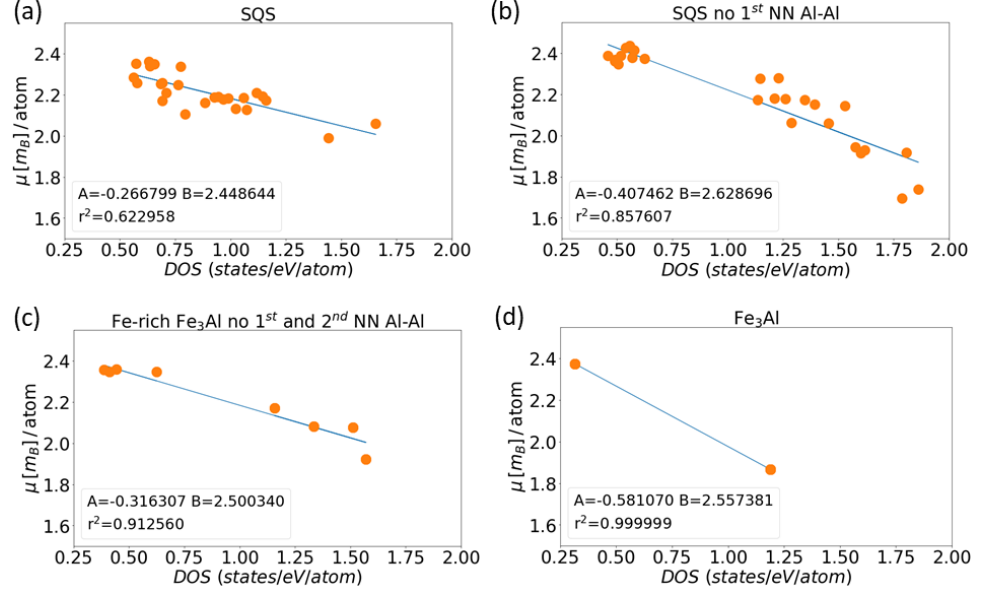
Figure 5. The dependences of local magnetic moments of Fe atoms on the density of states of these atoms (A and B represent coefficients in a linear fit y = A × x + B and r 2 is the coefficient of determination): ( a ) a general Fe-Al SQS, ( b ) an SQS without the first NN Al-Al pairs, ( c ) Fe-rich Fe 3 Al without the first and the second nearest neighbour Al-Al pairs, and ( d ) Fe 3